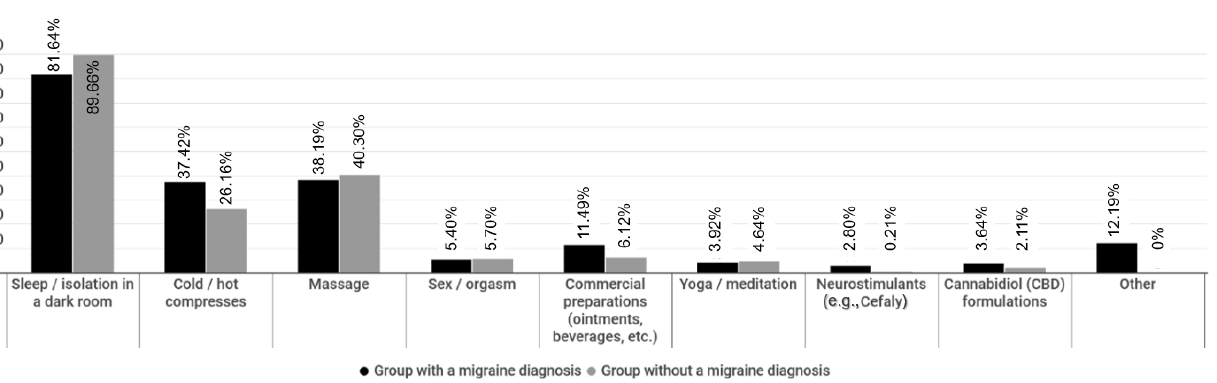
Figure 3. Alternative acute migraine treatments in both group A and B patients.